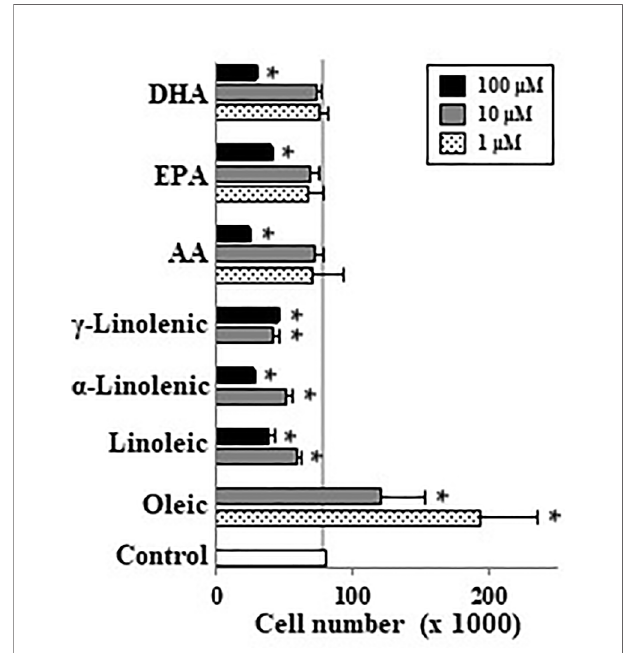
FIGURE 2 | Effect of different LCFA on Caco-2 cell growth in presence of 10% FBS. Oleic, linoleic, a -linolenic, g -linolenic, AA, EPA, and DHA were incubated with Caco-2 cells at 1, 10, and 100 µM (dot, gray, and black bars, respectively) in presence of 10% FBS for 48 h and were then counted. Results are expressed like mean ± SEM (n = 4 – 12). *P < 0.05 vs. control group (white bar, cells cultured with 10%